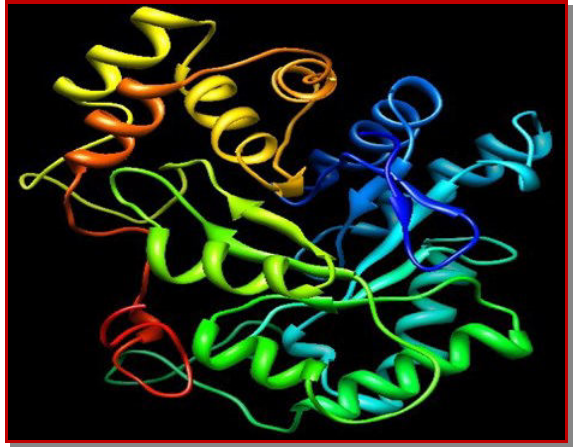
Figure 1: Refined aldose reductase enzyme from RCSB